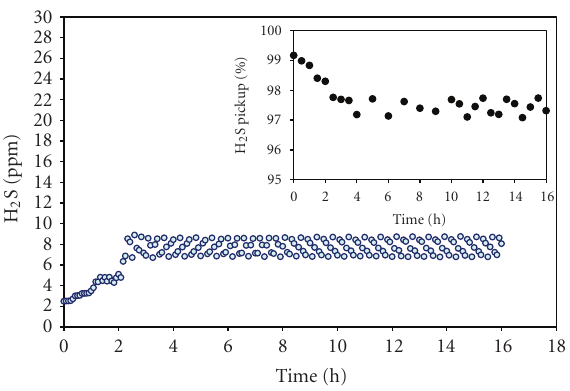
Figure 9: Evidence of sulfur pick-up propensity of pure GDC at 800 ◦